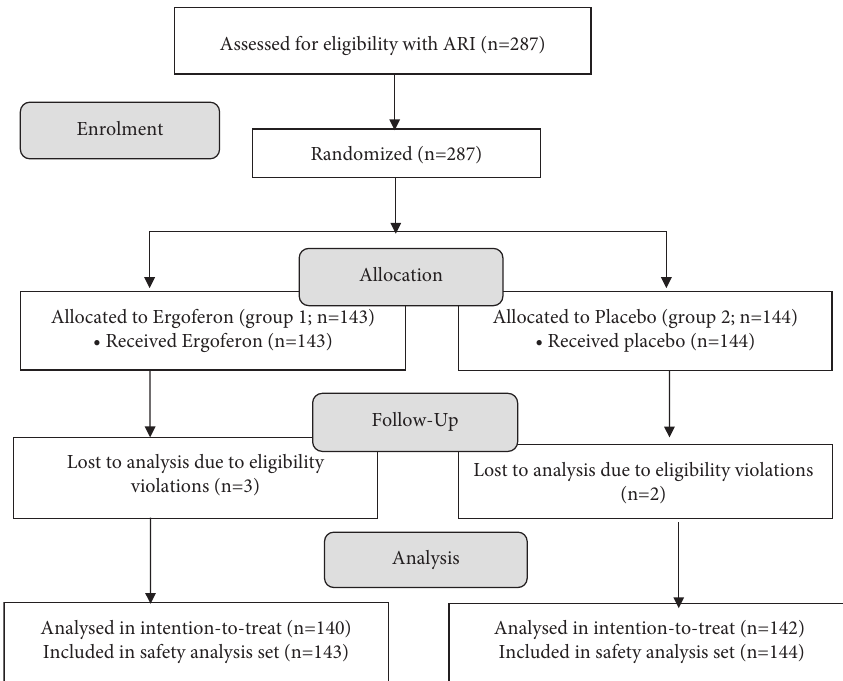
Figure 1: Study design flow